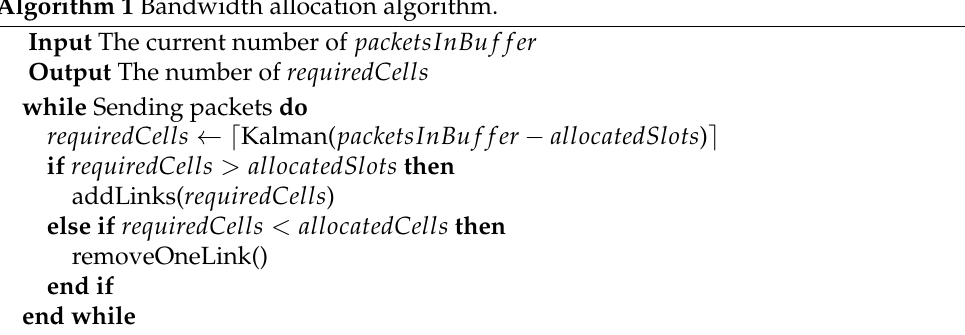
Algorithm 1 Bandwidth allocation